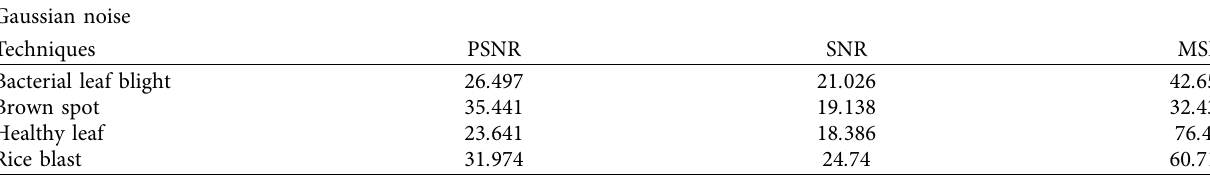
Table 2: Performance